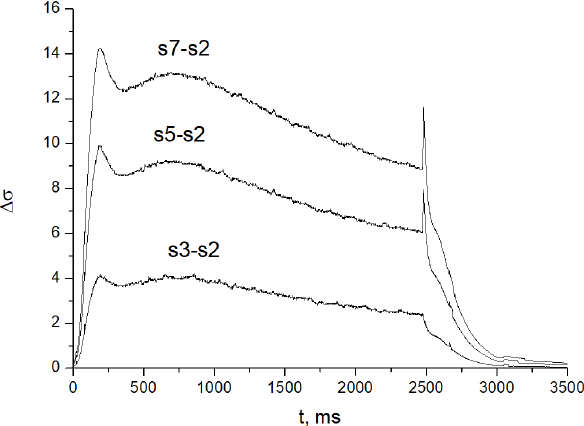
Figure 8. Time difference signal of the SmS-based sensor conduc- tivity change for three different concentrations of solvent vapors in atmospheric air (heating and